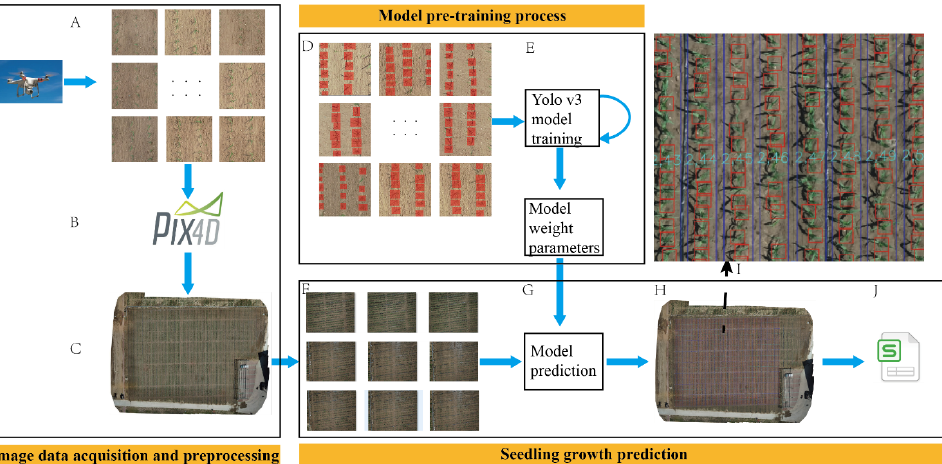
Figure 1. Workflow of image preprocessing and model prediction. ( A ) Images captured by an unmanned aerial vehicle (UAV); ( B ) Pix4d software was used to splice images captured by the UAV into a large image; ( C ) calibrated image; ( D ) labeled image; ( E ) model training process; ( F ) split the large image into small patches (608 × 608 pixels) for model input; ( G ) load model parameters for model prediction; ( H ) result image of model output; ( I ) enlarged view of the output marked image; ( J ) numerical results of model